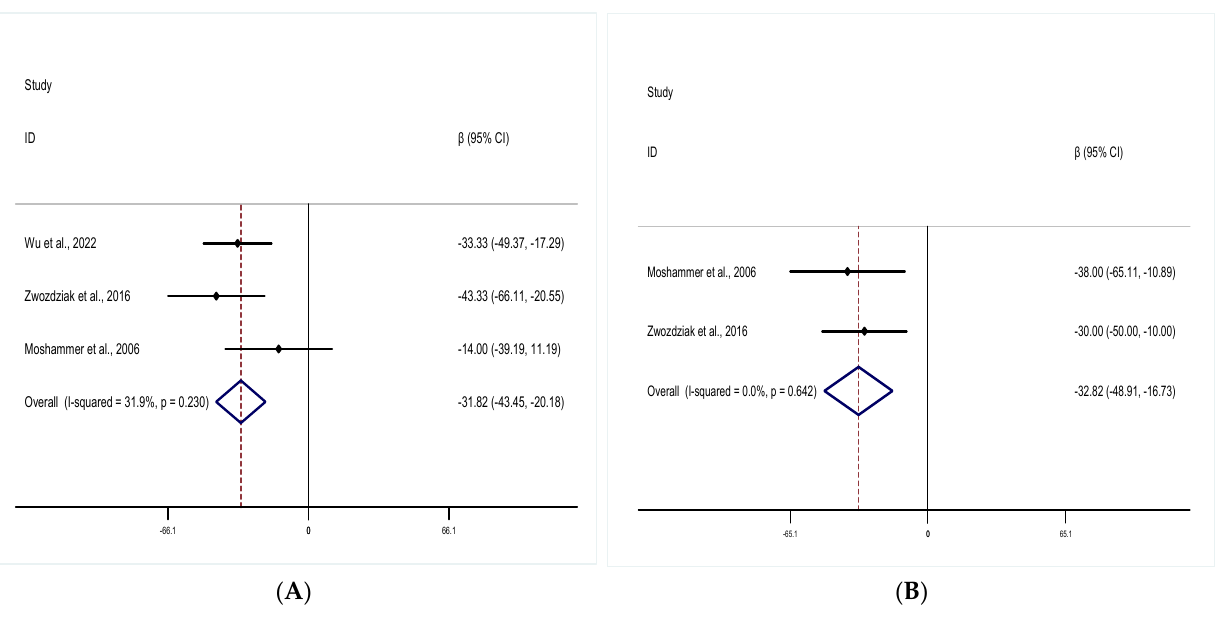
( D ) Figure 2. Forest plot of the meta-analysis: per 10 μ g/m 3 increase of PM 1 was associated with pooled β values of lung function indicators in the short-term group: ( A ) FVC, ( B ) FEV 1 , ( C ) PEF, ( D ) MMEF [31,32,36]. The open diamonds represent the combined β value for each group. The solid line repre- sents β value = 0.